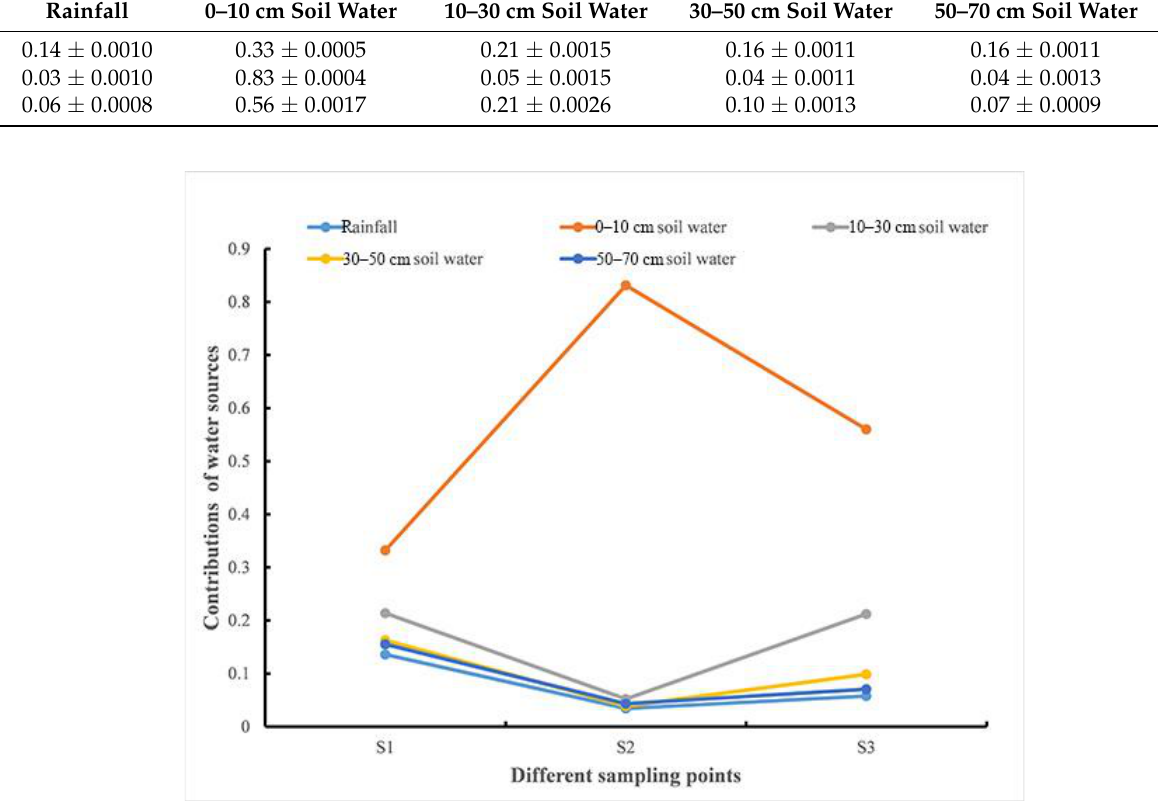
Figure 5. The relevance of contributions of various water sources to Cynanchum sibiricum during growth period.